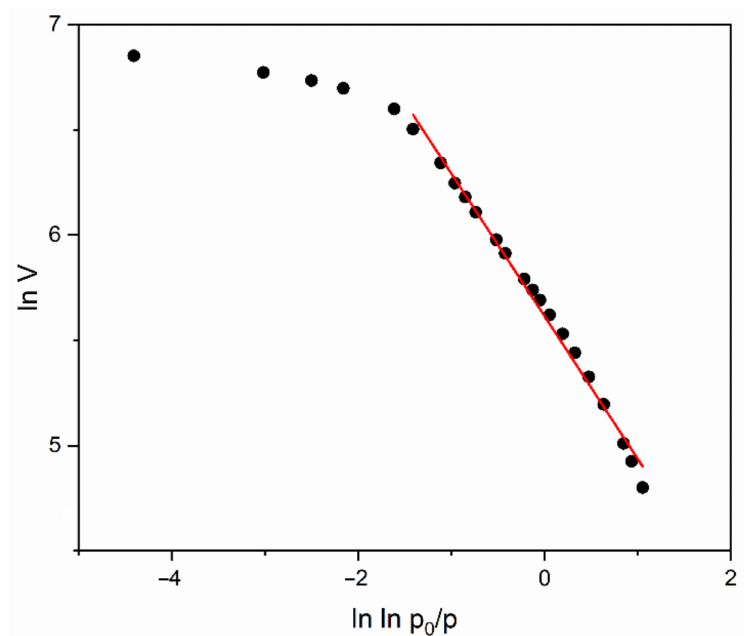
Figure 6. Linear fit (red line) of the low pressure adsorption region of sample MJ4 with α =